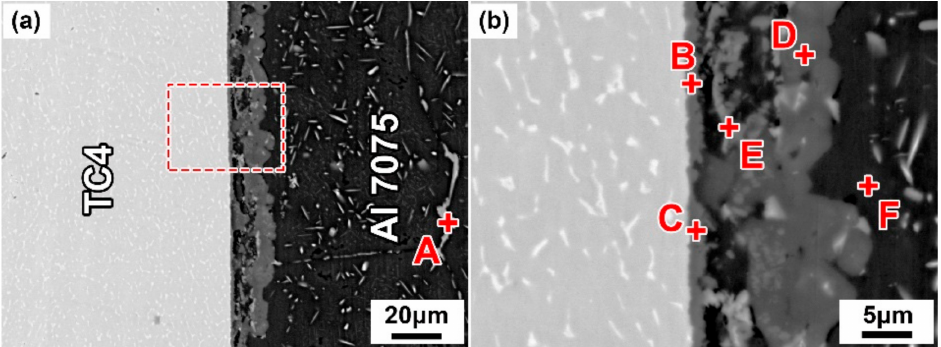
Figure 2. Interfacial microstructure of TC4/Cu layer/Al7075 alloy brazed joint at 600 ◦ C for 30 min. ( a ) Low magnification; ( b ) High